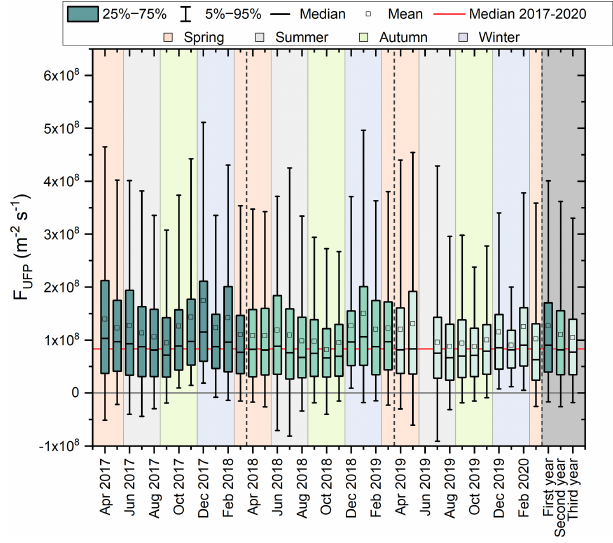
Figure 7. Variation of monthly and annual F UFP during the study